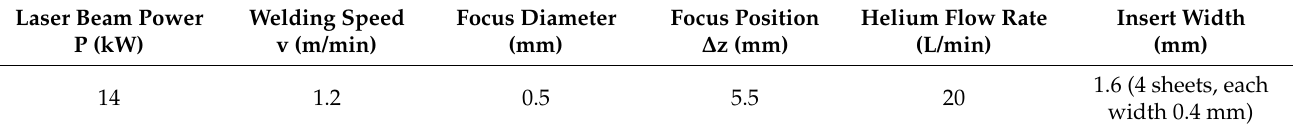
Figure 1. Scheme of the welding process. Table 1. Welding